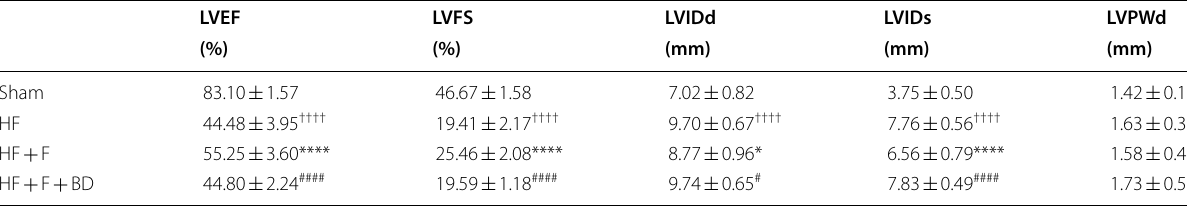
LVEF, left ventricular ejection fraction; LVFS, left ventricular systolic percentage; LVIDd, left ventricular end-diastolic internal diameter; LVIDs, left ventricular end- systolic inner diameters; LVPWd, left ventricular posterior wall diastole; † P HF group vs sham group; *P HF